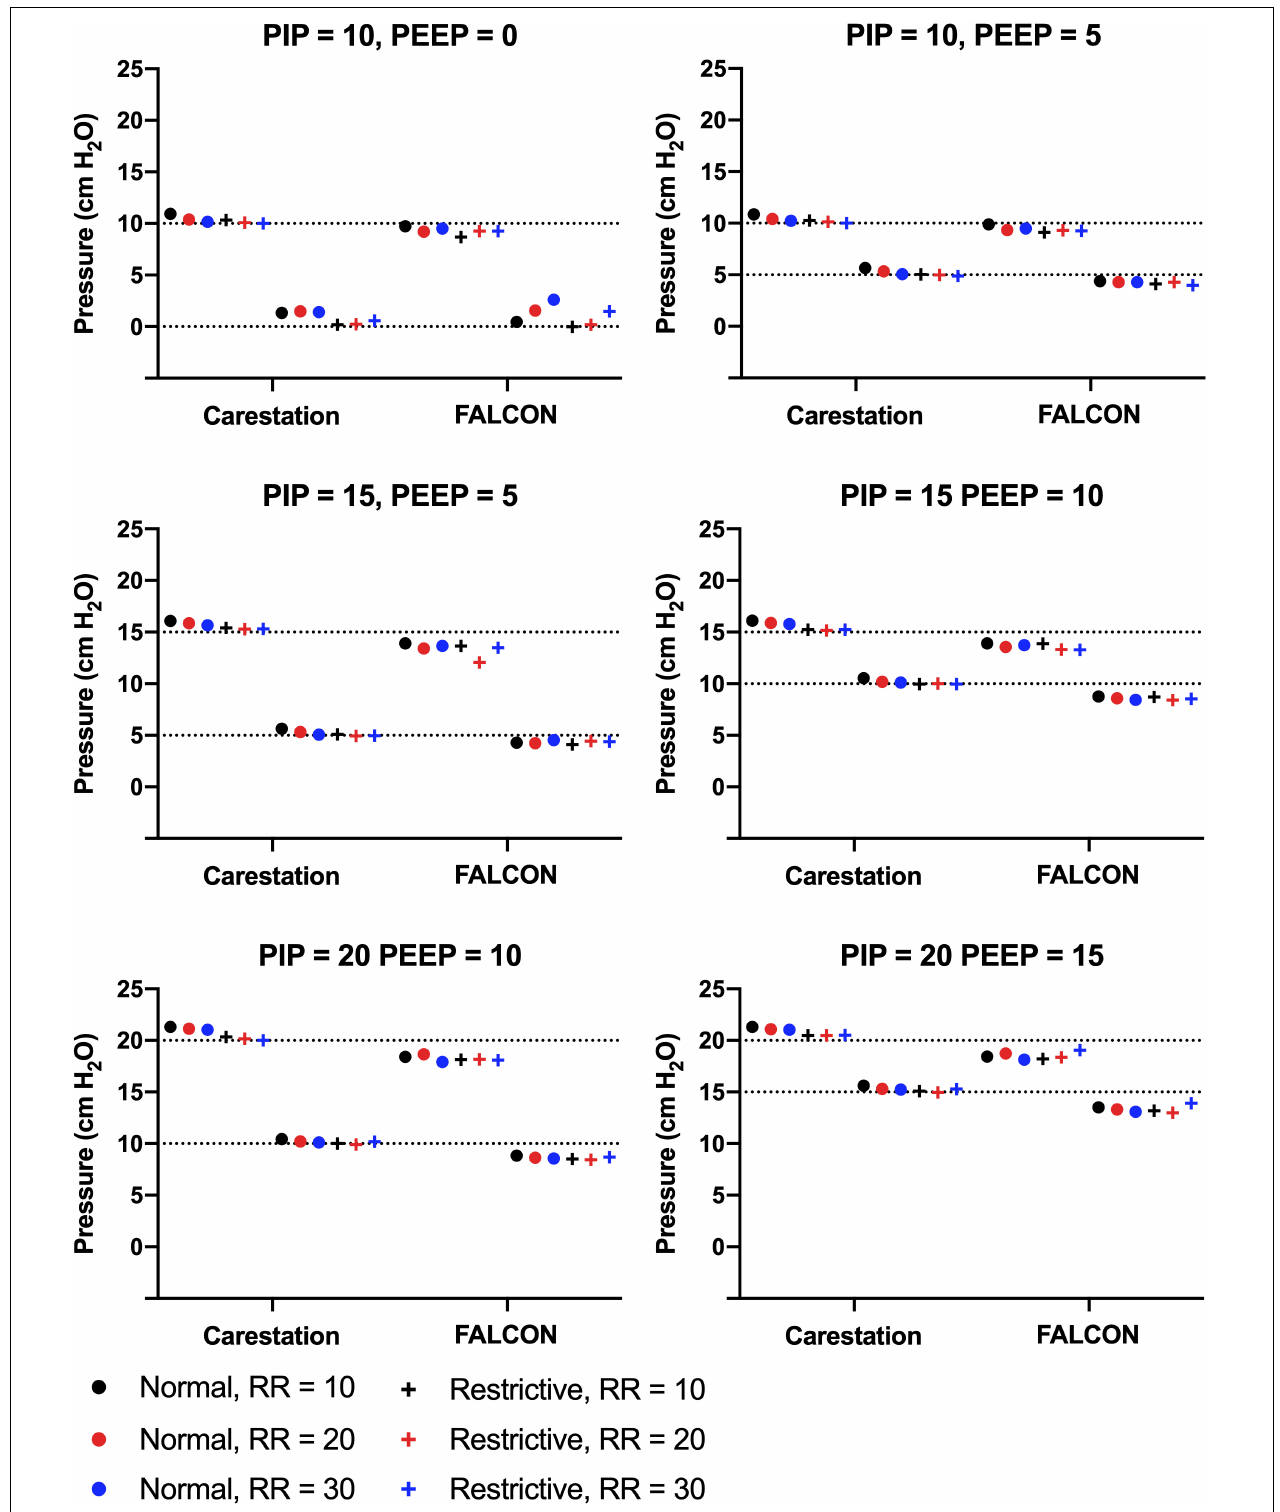
FIGURE 5 | Mean peak inspiratory pressure (PIP) and positive end expiratory pressure (PEEP) generated by the CarestationTM and FALCON prototype ventilators measured from 10 consecutive respiratory cycles in all test conditions. Data are grouped by target PIP and PEEP with varying lung compliance (normal = 74 mL/cm H 2 O or restrictive = 34 mL/cm H 2 O) and respiratory rate (RR; 10, 20, or 30 breaths per min). Dotted lines indicate target PIP and PEEP.